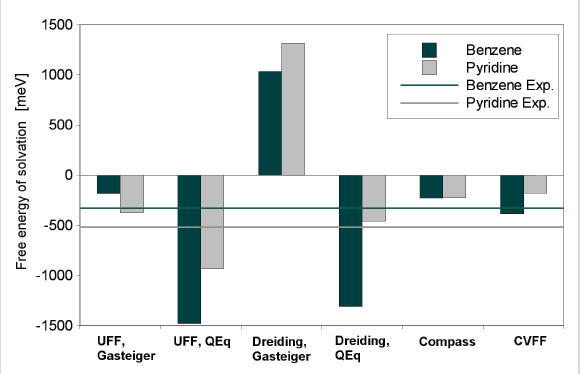
Figure 5: Force field molecular dynamics result for the free energy of solvation E solv for pyridine and benzene in water. Experimental values taken from [35].